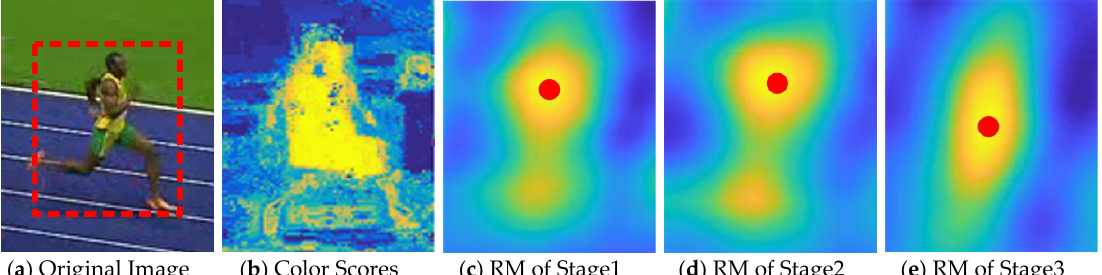
deep stage are closer to the center of the tracking target.